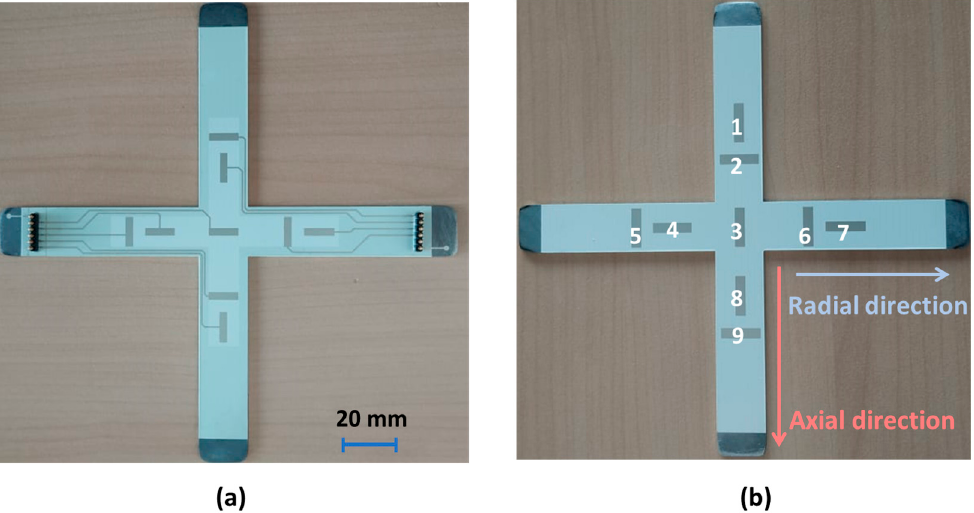
Figure 12. Cross-shaped sensor network coated with rectangular electrodes: ( a ) full printed coating with CTs and DL; ( b ) simple coating without CTs and DL.